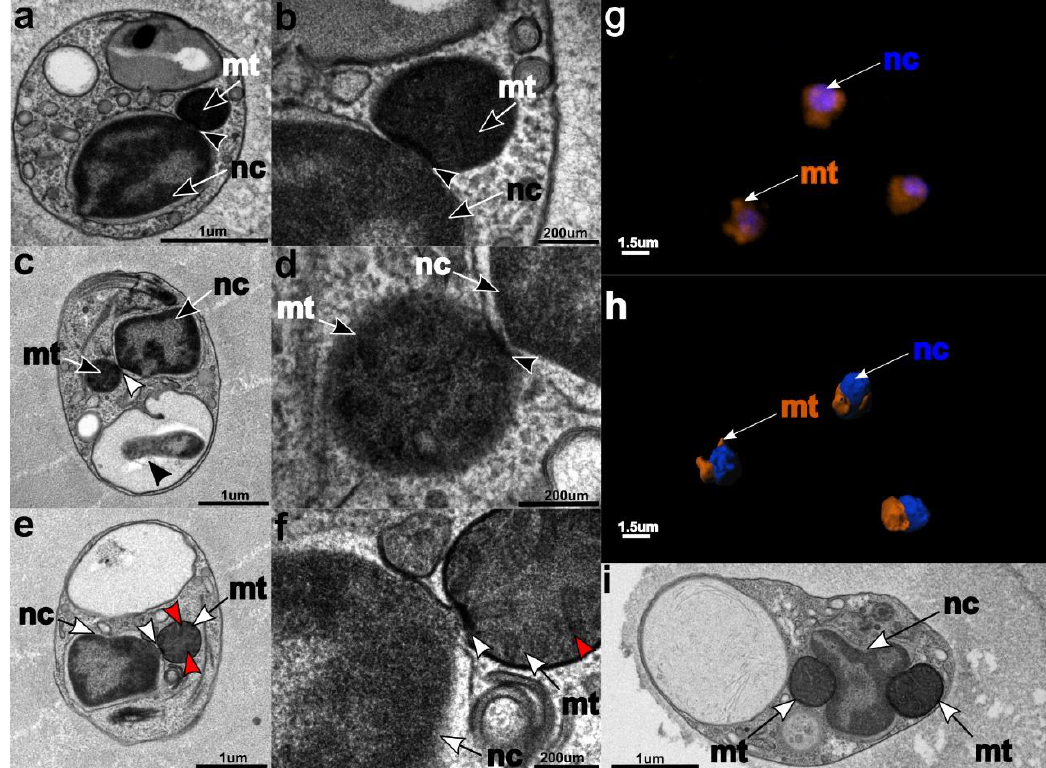
Figure 2. Connections between the nucleus (nc) and the mitochondria (mt) were documented several times independently (white arrows) ( a , b , c , d , e , f ). The bicosoecids’ mt has tubular cristae ( e , f : red arrows). The connection of organelles was also observed using fluorescent staining of nc and mt and using confocal microscopy ( g ). Confocal Z-stacks were transformed into the 3D model ( h ) and mt appear in a location close to the nc. Mt can vary in shape and size, ranging from a simple spherical shape to a horseshoe shape, which is usually “hugging/wrapping” the whole nc ( i ). In the panel ( c ), devoured bacteria are visible in the food vacuole (black arrow).